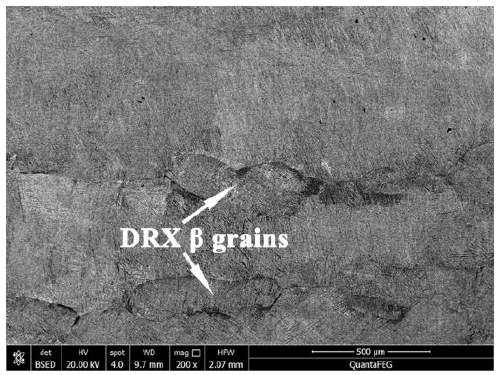
Figure 12. Microstructures of Ti-6Al-4V specimens deformed at 1050 °C/10 −3 s −1 .